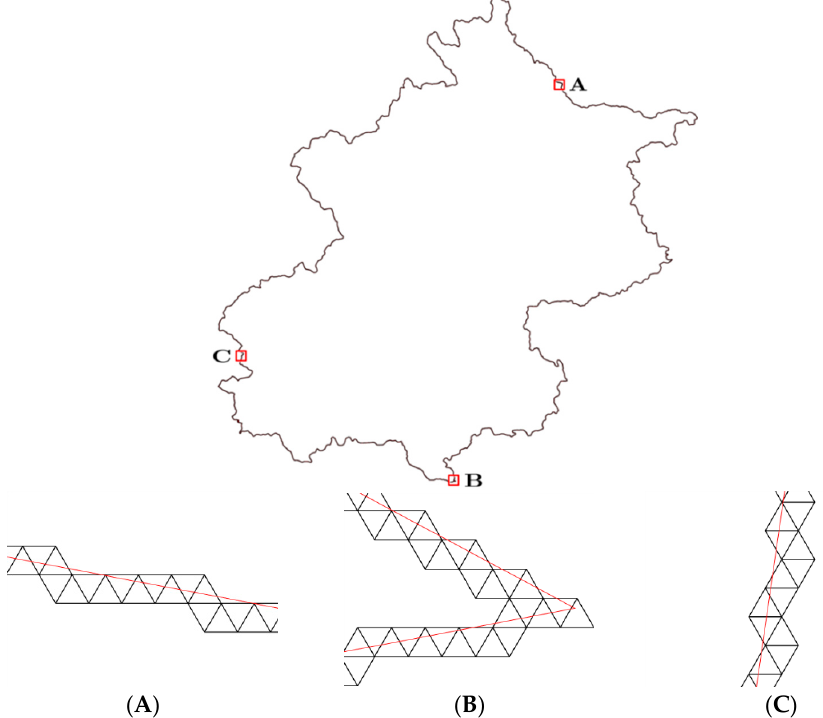
Figure 11. Detailed results of the proposed algorithm (side length of grid cell is approximately 3 m), indicating the fitting relationship between the discrete line and actual vector data ( A ) for an inclined line; ( B ) at a corner; and ( C ) for a vertical line.